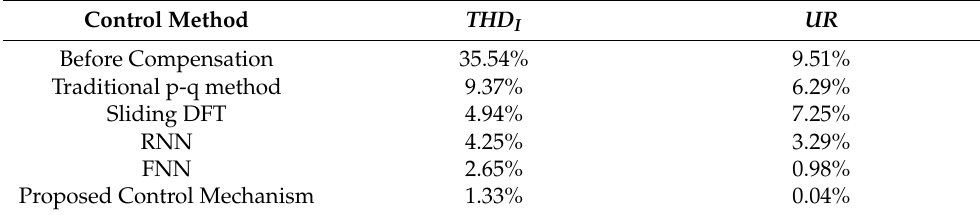
Figure 9. Experimental result of the proposed control mechanism for case 1. Table 2. Experimental results for case